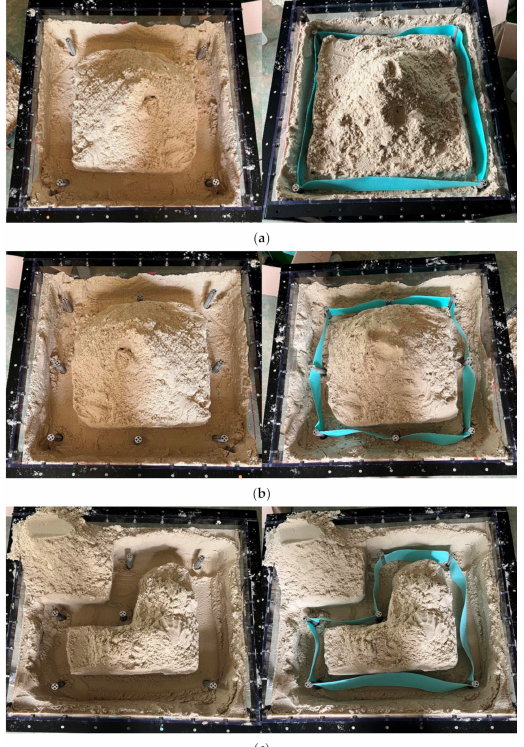
Figure 12. Results of experiments for RSIM: square using ( a ) 4-supporting, ( b ) 8-supporting, and ( c ) multisection area.